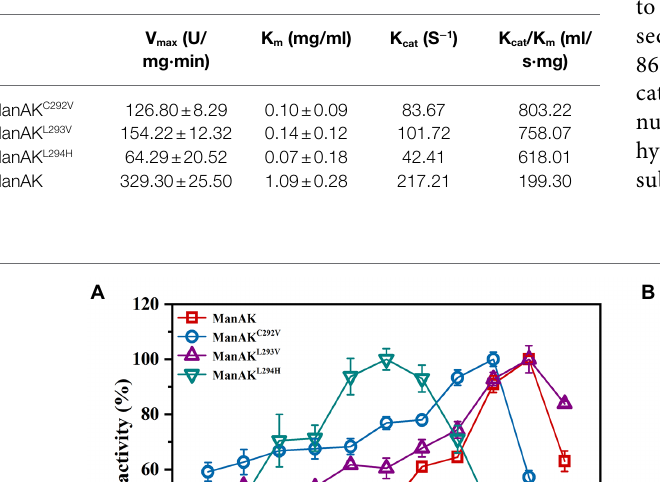
TABLE 2 | Kinetic parameters of ManAK, ManAK C292V , ManAK L293V , and ManAK L294H .